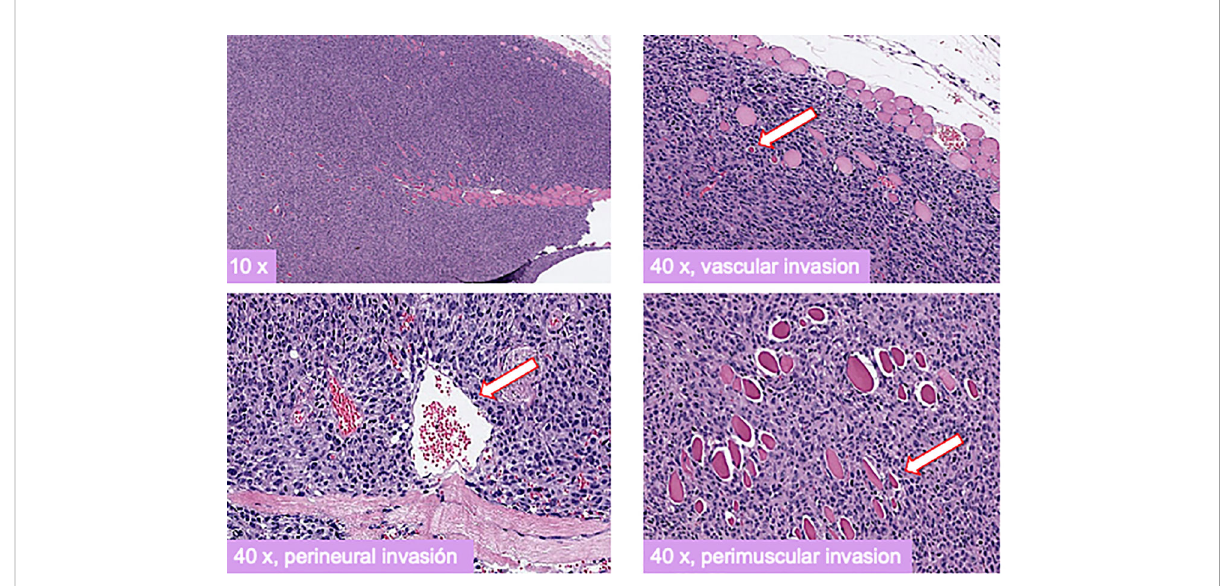
FIGURE 12 Xenotransplants of the breast cancer cells derived from a patient with obesity displayed a more aggressive tumorigenic and invasive activity compared to those derived from a patient with normal weight. Histopathology of H&E-stained slides from tumors generated 3 weeks after implantation of cell from the DSG-BC2 cell line. Images were taken at the indicated magni fi cations. White arrows indicate transversal section of a vascular structure (upper right panel), transversal section of a nerve (lower left panel), and transversal section of a muscle fi ber (lower right panel). Samples were processed as described in Materials and methods